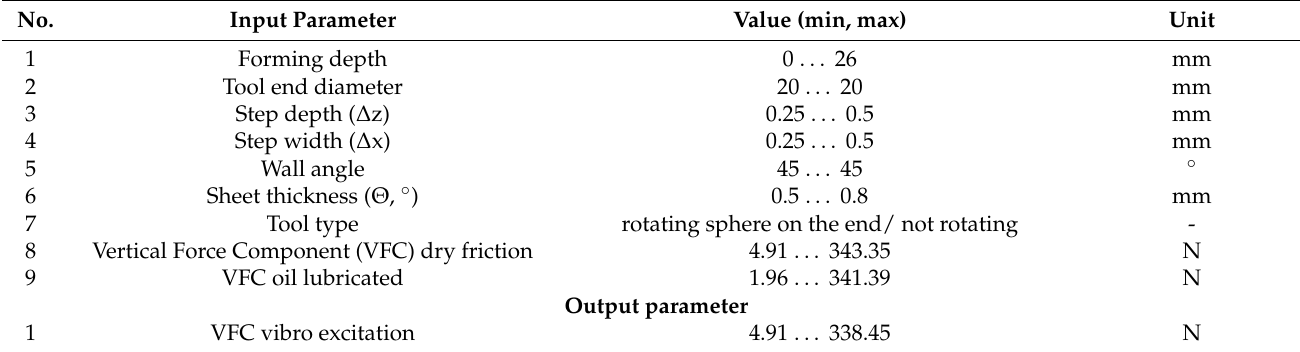
Table 4. Parameters for data exploration.